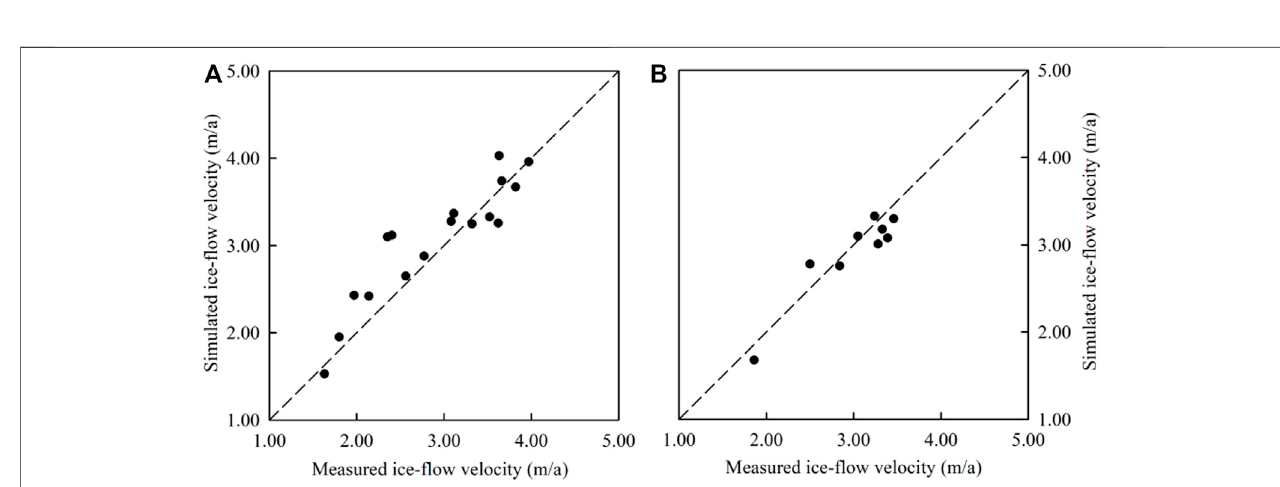
FIGURE 8 | Error graphs of (A) the EB and (B) the WB using the best estimates of the model parameters. The black points denote ice- fl ow velocities at the stakes depicted in Figure 3 . The dashed line denoted the states when the measured ice- fl ow velocities were equal to the simulated ice- fl ow velocities.